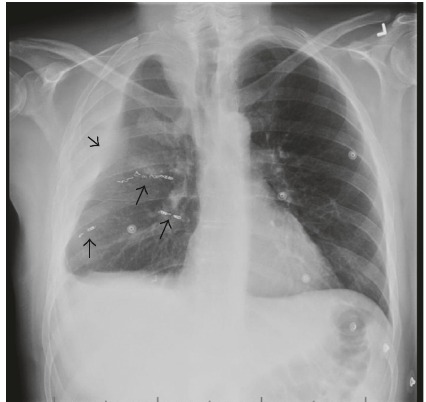
Figure 4: Chest X-ray of the patient on the day of discharge shows metallic coils in the intercostal arteries (arrows) and residual volume loss in the right lung (arrow head) following